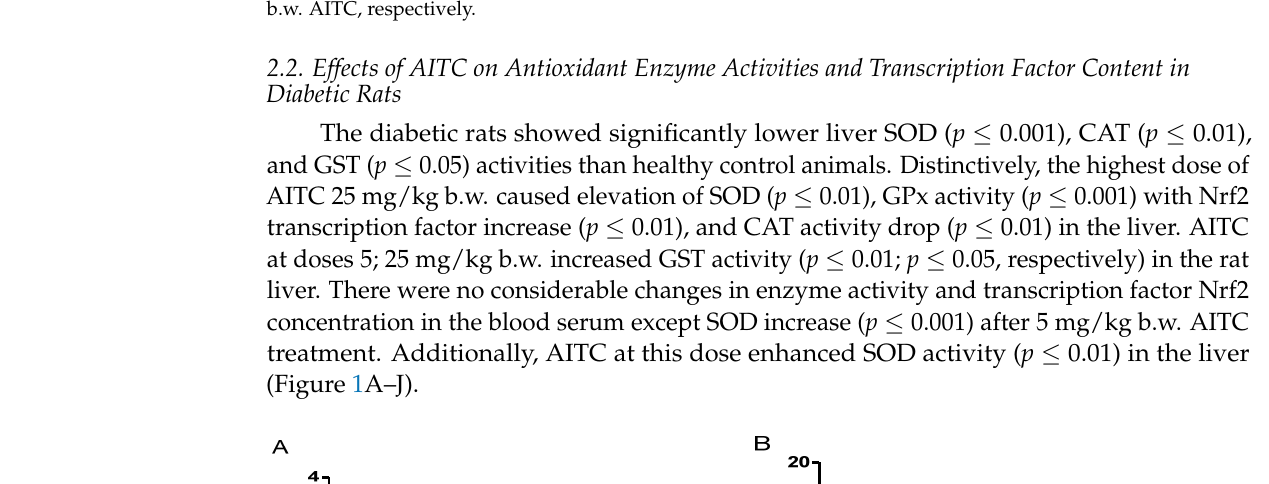
Figure 1. Effects of AITC on antioxidant enzyme activities: SOD ( A , B ), GPx ( C , D ), CAT ( E , F ), GST ( G , H ) and Nrf2 transcription factor contents ( I , J ) in the liver and the blood serum of diabetic rats.Each column represents the mean ± SEM ( n = 8). * p ≤ 0.05, ** p ≤ 0.01, *** p ≤ 0.001 compared